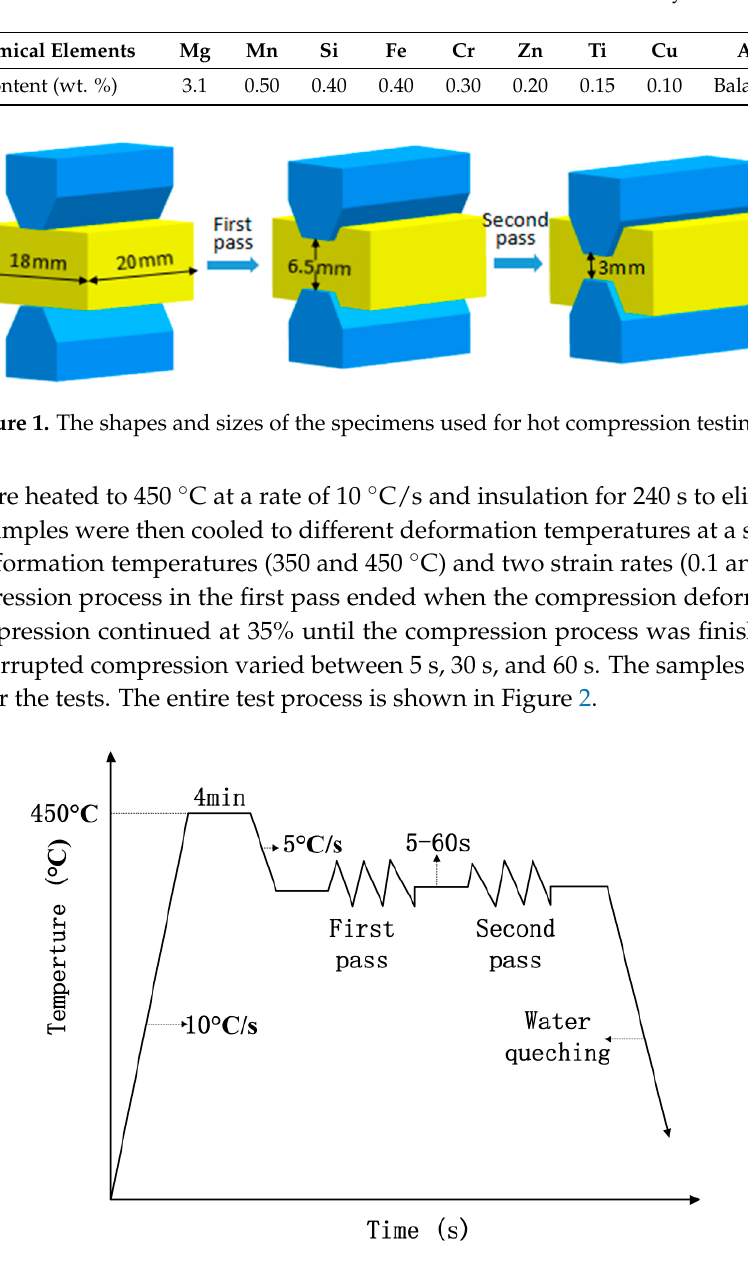
Figure 2. Experimental process for the double pass compression tests.